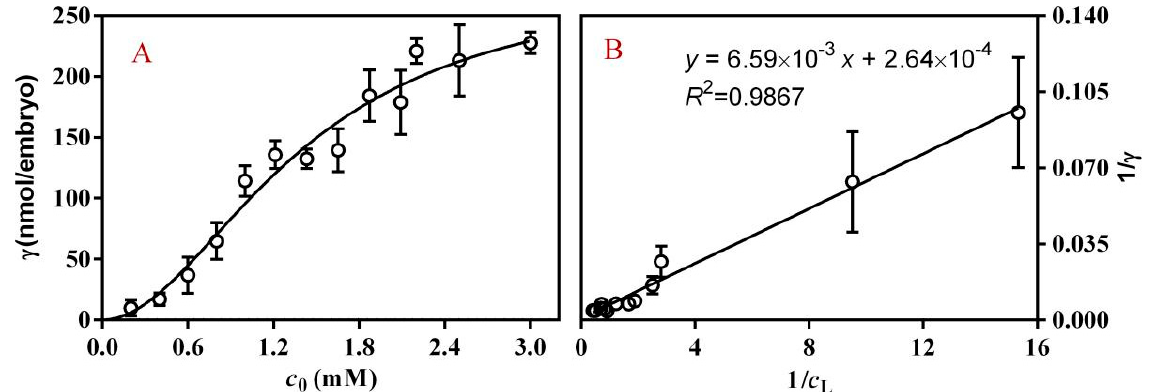
Figure 2. ( A ): The change of γ binding on zebrafish embryos ( n = 5) after the embryos had been incubated with PFLX for 8 h; ( B ): Plot of 1/ γ vs. 1/ c L .